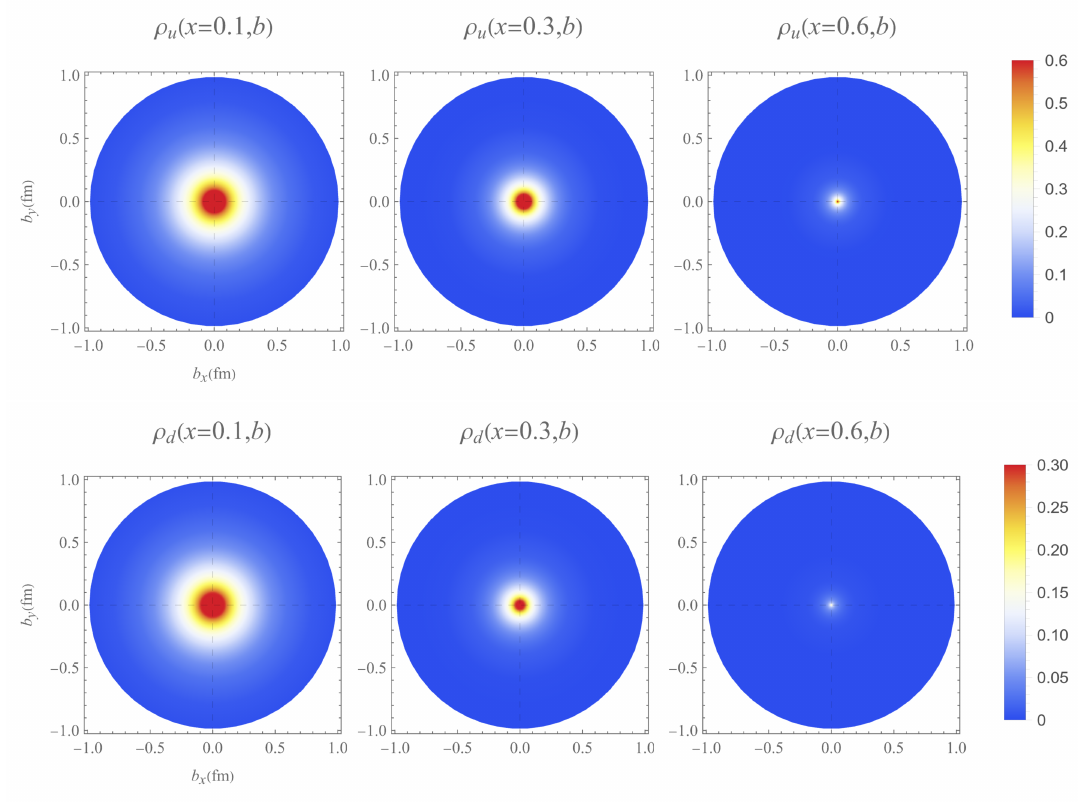
Figure 10 . Plots of quark densities ρ q ( x, b ) for both u (the upper row) and d (the lower row) quarks in unpolarized proton with increasing momentum fraction x . The densities typically get more concentrated but suppressed for increasing x